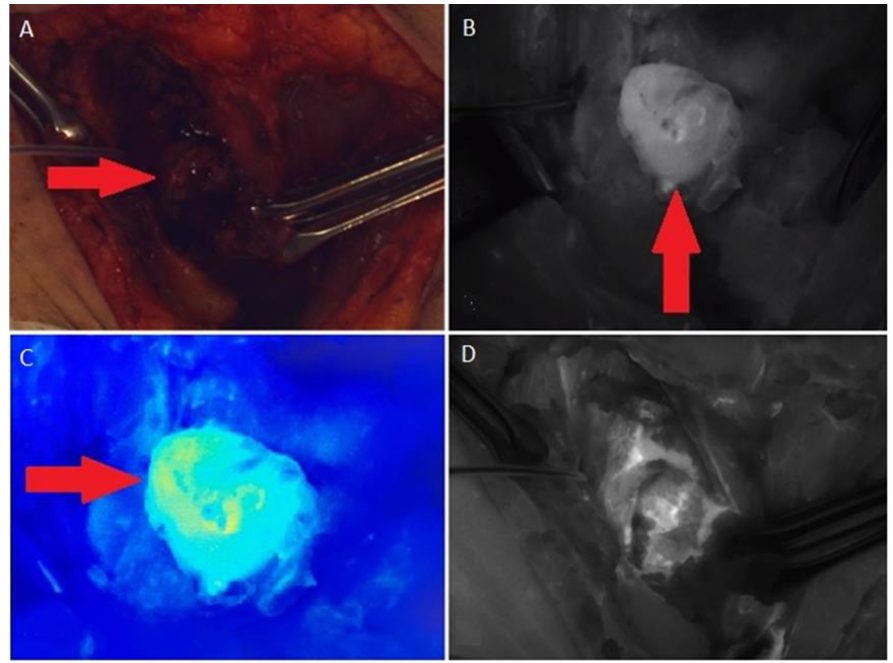
Figure 3. ( A ) The surgical field in the visible spectrum, the lesion ( → ) has been accessed; ( B ) The tumor ( ↑ ) in the infrared spectrum with the light off, 90 s after intravenous administration of ICG; ( C ) Intensive blood supply to the tumor ( → ), in the color spectrum; ( D ) The surgical field after tumor removed.